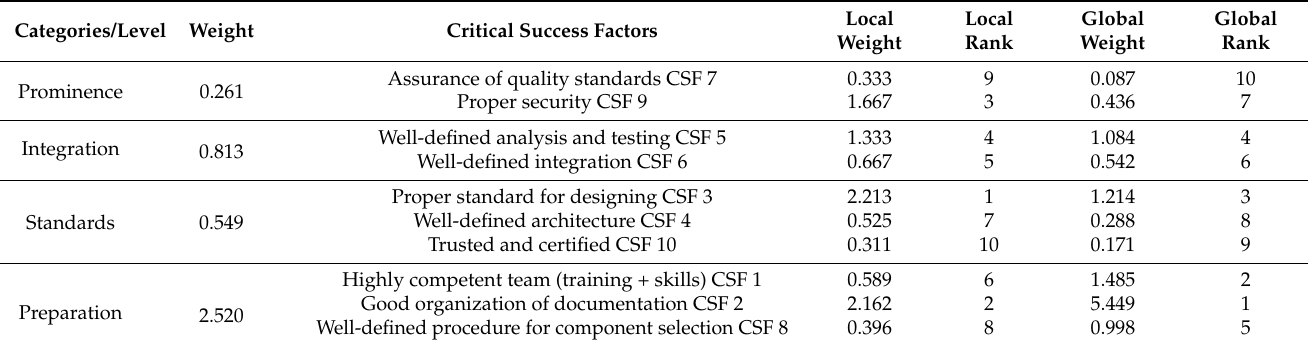
Table 26. Summary of local and global weights success factors and their